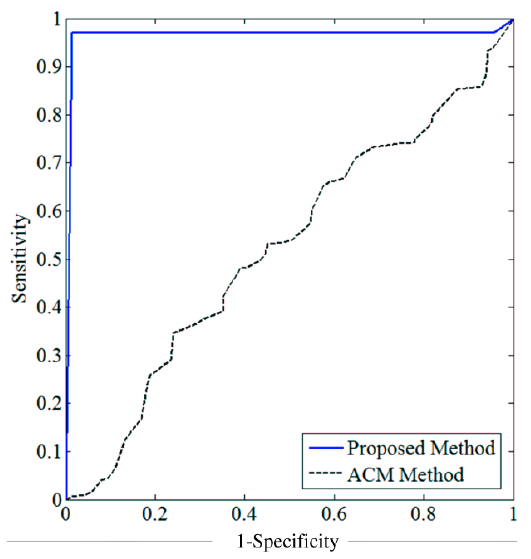
Fig. 6. ROC curve.